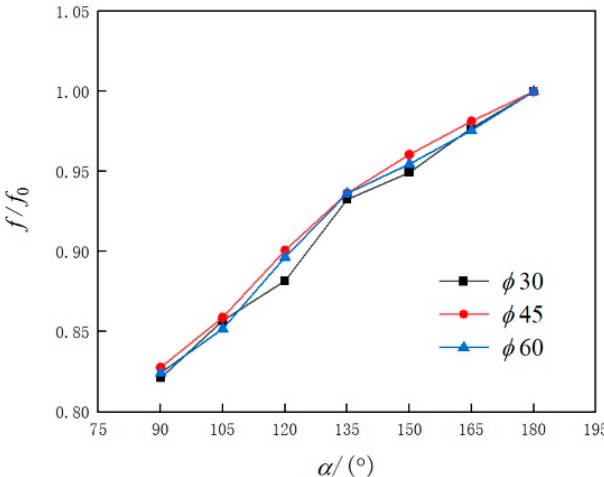
Figure 12. Relative frictional resistance coefficient f / f 0 changing with the central angle α for straight pipes.